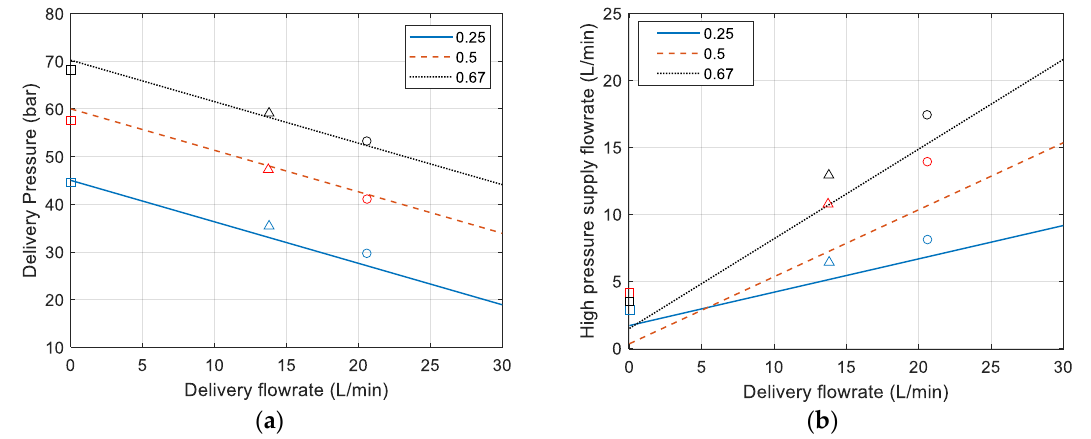
Figure 6. Experiment and analytical results of flow booster. ( a ) Delivery pressure versus delivery flow rate; ( b ) high-pressure supply flow rate versus delivery flow rate.